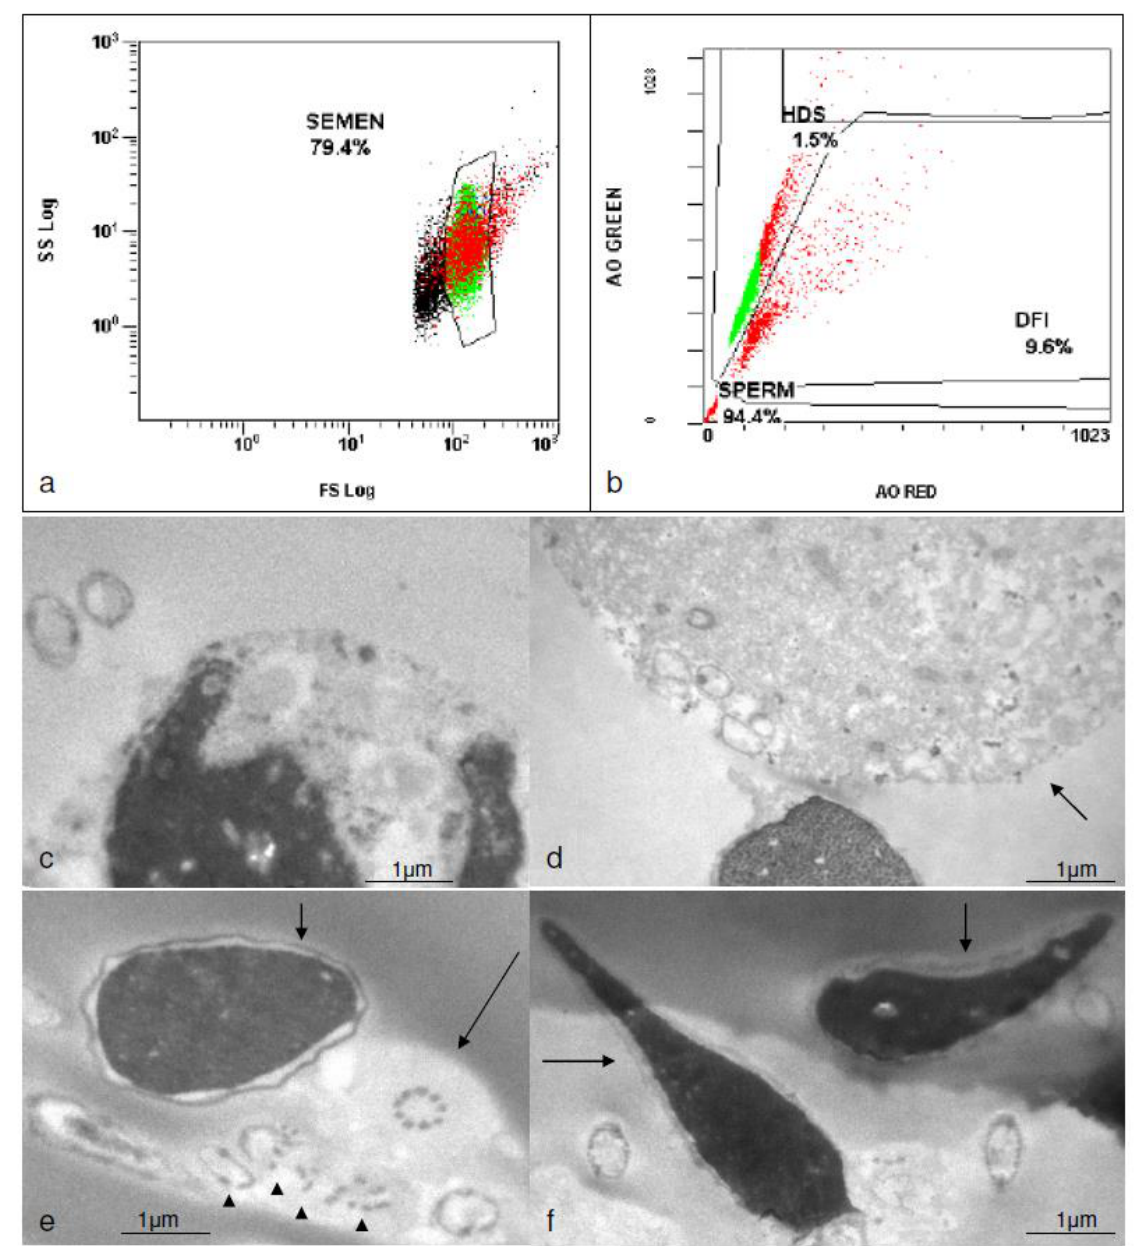
Figure 2. Assessment of DNA fragmentation by flow cytometry ( a – b ) and TEM photomicrographs ( c – f ) of the frozen sample under therapy with celecoxib and sulphasalazine; note that in ( c ) a neutrophil, in ( d ) a degenerating spermatid (arrow), in ( e ) a longitudinal section of a sperm head with a rounder shape and without a pointed acrosome (small arrow) and cross sections of tails with normal outer dense fibers and axonemal pattern (long arrow) and abnormal patterns (arrow heads), in ( f ) a longitudinal section of a normal sperm head (long arrow) and an abnormally shaped slightly bent sperm head with vacuoles (small arrow).